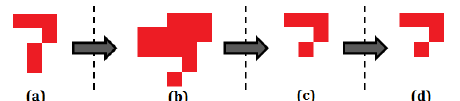
Figure 8. Change in spatial distribution of the Tropical climate zone (A2) in North-Eastern India : (a) 1901-1925 , (b) 1926-1950 ,